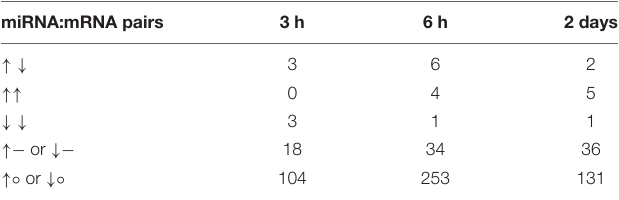
TABLE 1 | Putative miRNA:mRNA target pairs and their relative expression patterns upon 3 h, 6 h, and 2 days of high light treatments. miRNA:mRNA pairs